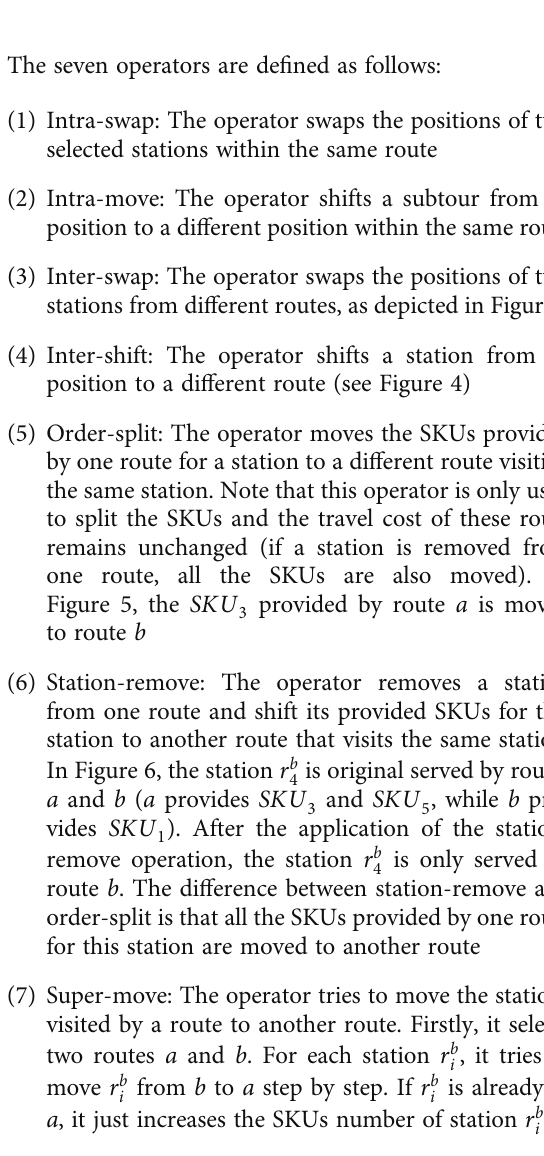
Algorithm 1: VNS for the